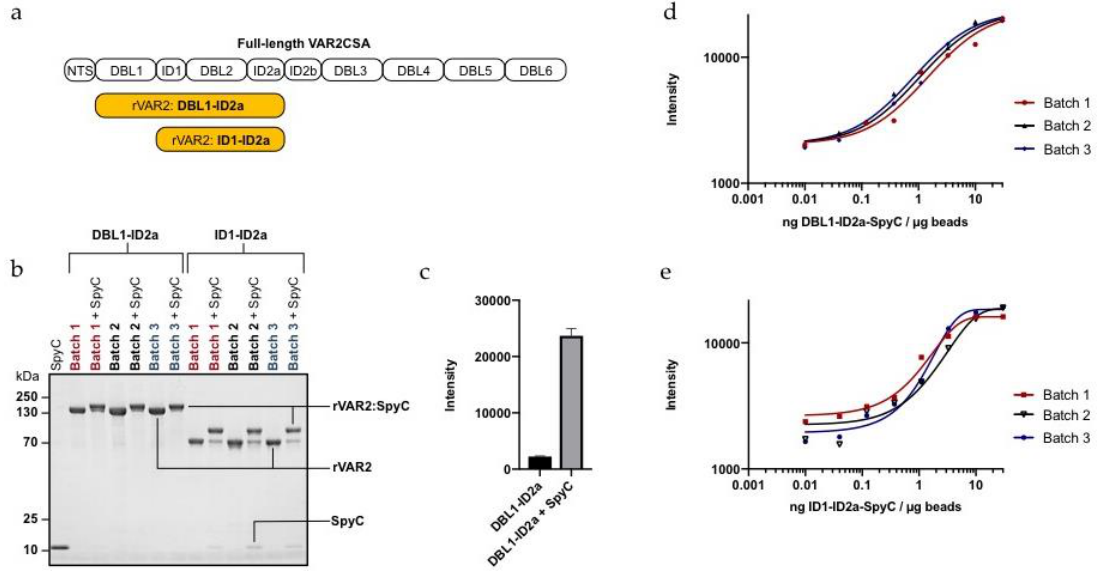
Figure 1. rVAR2-SpyC-coating of magnetic particles. ( a ) Schematic figure showing the domain structure of full-length VAR2CSA and the two recombinant subfragments (DBL1-ID2a and ID1-ID2a) used in this study (rVAR2, yellow). ( b ) SDS-PAGE showing the size-shift induced by coupling of biotinylated SpyC with different batches of SpyTagged DBL1-ID2a or ID1-ID2a. ( c ) Fluorescence intensity of anti-V5 FITC detection of DBL1-ID2a binding to Sera-Mag beads (30 ng rVAR2 / µg beads) showing rVAR2 bead binding dependency on coupling to biotinylated SpyC. Columns represent means of triplicates and error bars show SD. ( d ) Fluorescence intensity of anti-V5 FITC signal plotted against various rVAR2-SpyC to bead ratios of three different DBL1-ID2a and ( e ) ID1-ID2a batches.